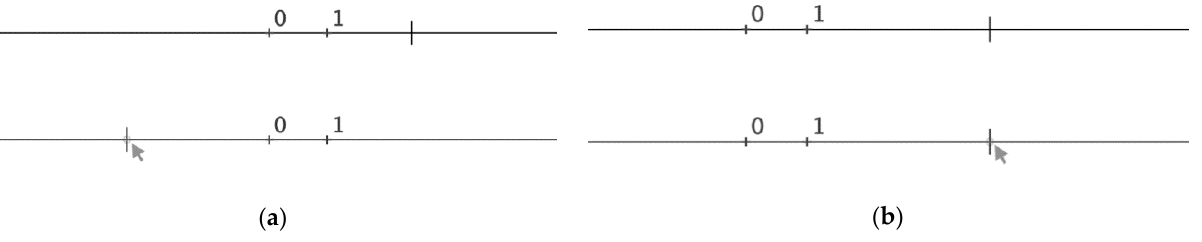
Figure 3. Two screenshots of the DGpp of the function 𝑓(𝑥) = |𝑥| . The mouse cursor identifies the tick representing the independent variable, which is the only draggable one. ( a ) A screenshot of the DGpp for a negative x -value; ( b ) A screenshot of the DGp for a positive x -value.